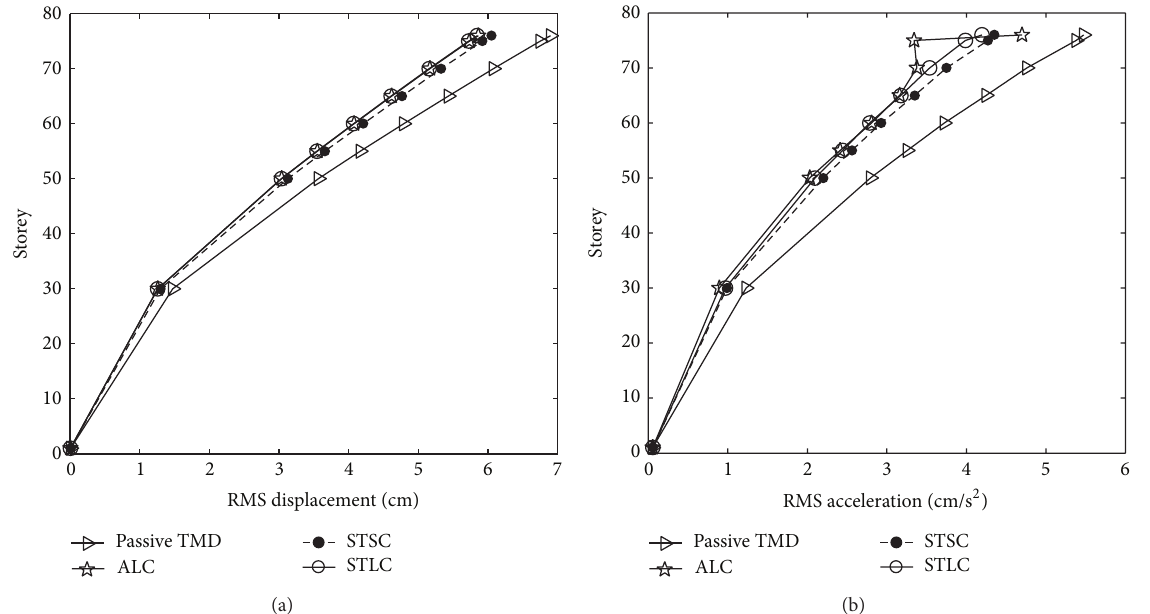
Figure 8: Comparison of RMS displacement and RMS acceleration ( 0 % stiffness